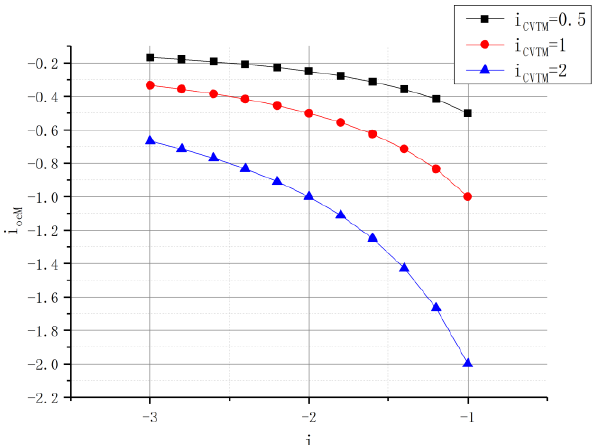
Figure 9. The transmission ratio, 𝑖 𝑜𝑒 .